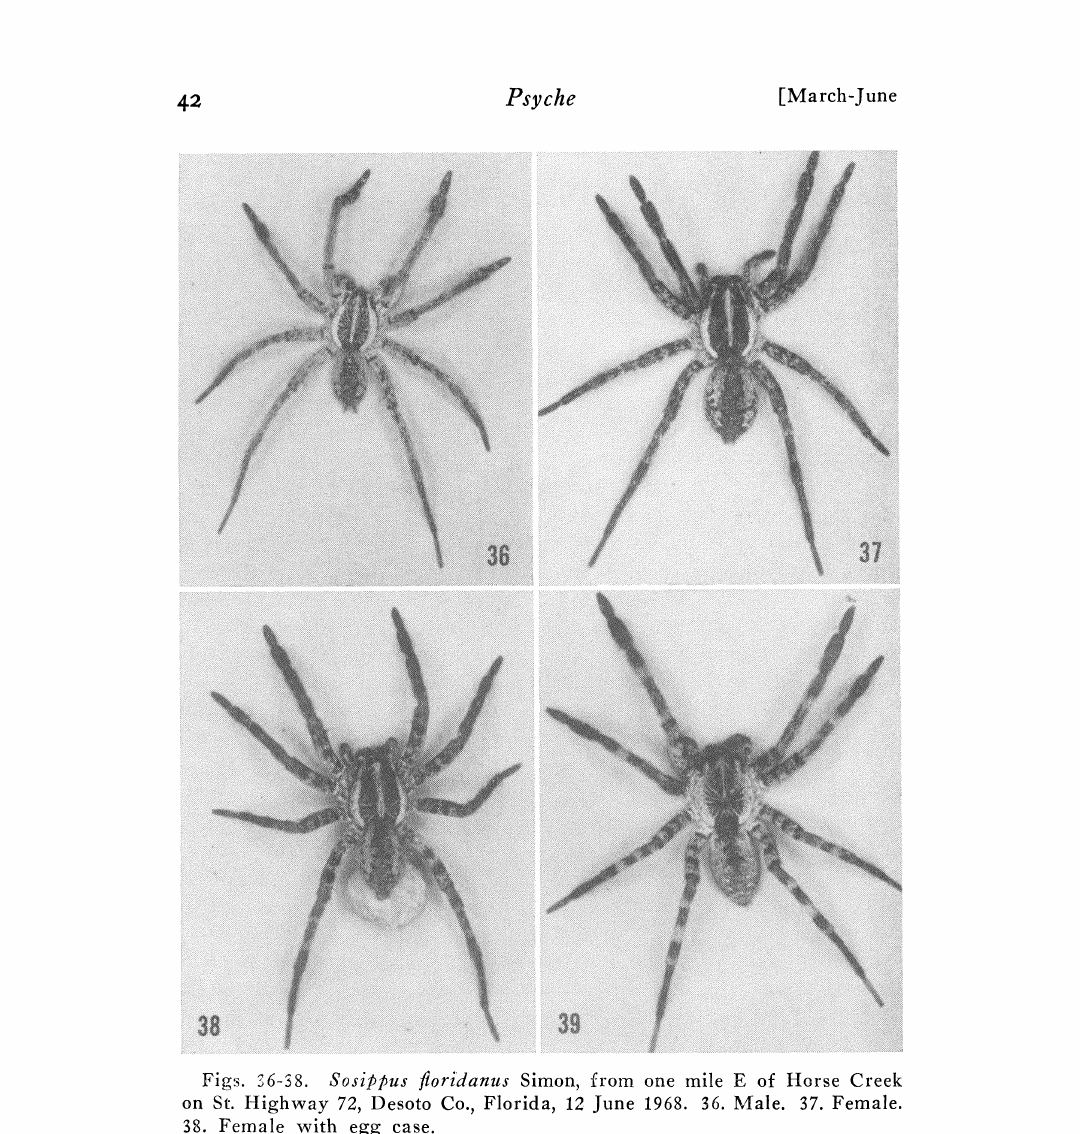
Figs. ";.6-38. Sosiptus fioridanus Simon, from. one mile E of Horse Creek on St. Highway 72, Desoto Co., Florida, 12 June 1968. 36. Male. 37. Female. 38. Female with egg case. Fig. 39. Female holotype of Sosippus placidus sp. n., from 6 mi. S of Lake Placid, Highlands Co., Florida, 12 June